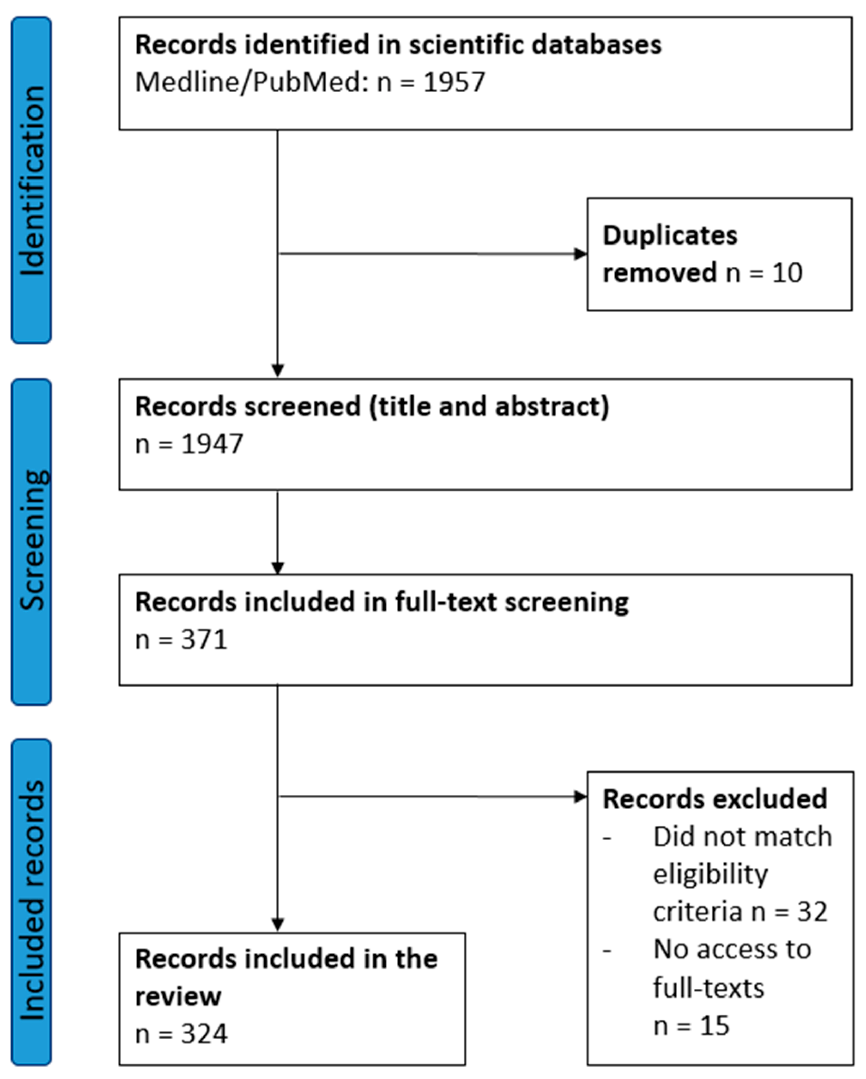
Figure 2. PRISMA flowchart. Table 1. Descriptive statistics of concept mentions across included articles ( n =